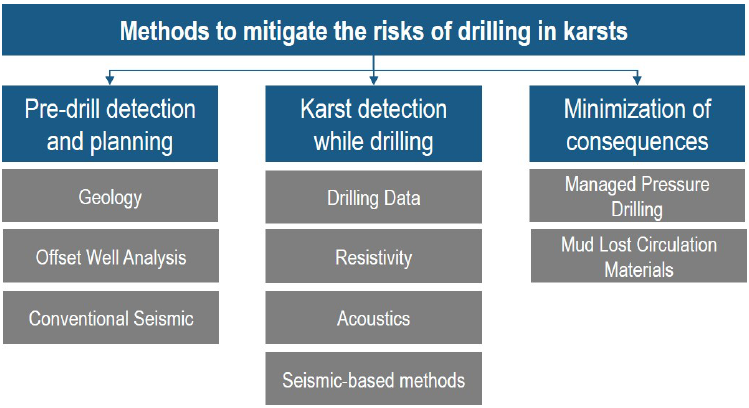
Figure 1. Methods to mitigate the risks of drilling in